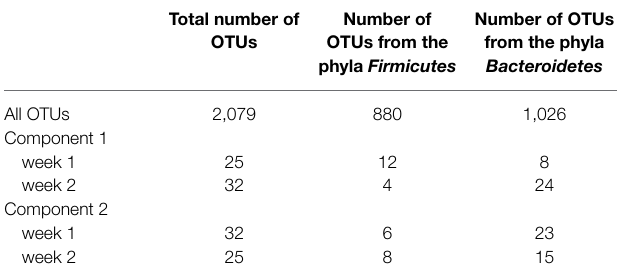
TABLE 3 | Number of OTUs belonging to the phyla Firmicutes and Bacteroidetes considering the 2,079 OTUs or the OTUs selected on the two main components for the sPLS-DA associated with each of the 2